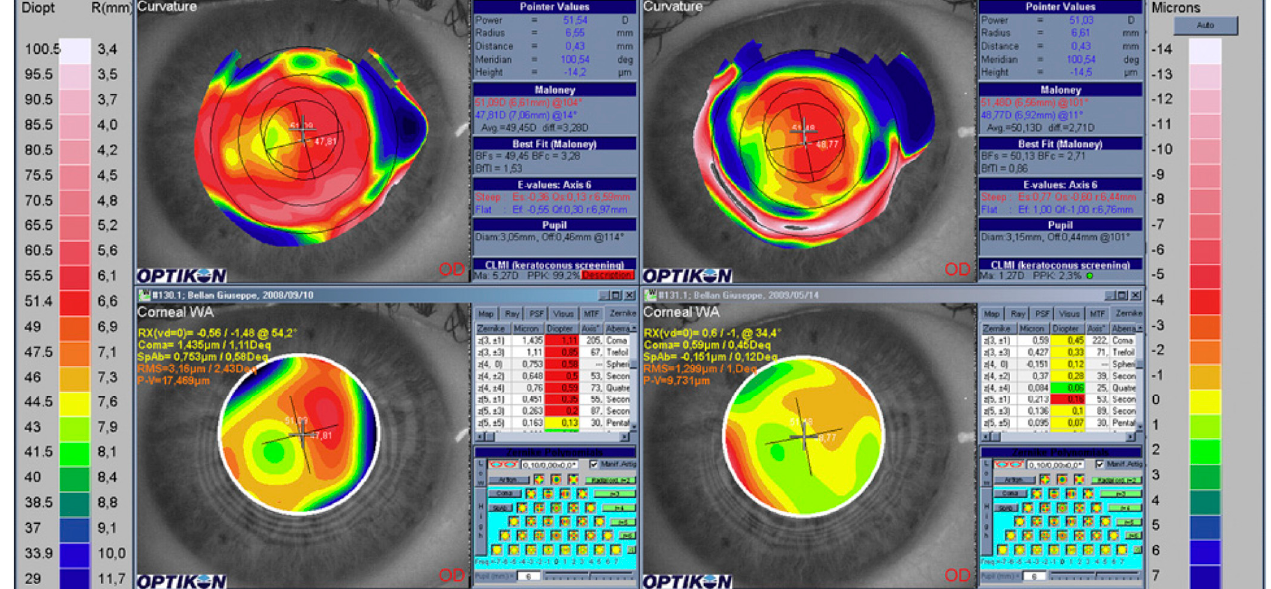
Figure 22. Maps of a post-RK eye. Top left: curvature map before simultaneous PRK–PTK. Top right: curvature map after simultaneous photorefractive keratectomy and phototherapeutic keratectomy (PRK–PTK). Bottom left: corneal wave aberration map before simultaneous PRK–PTK. Bottom right: corneal wave aberration map after simultaneous PRK–PTK. This figure was published in Ref. [112] Journal of Cataract & Refractive Surgery , M. Camellin and S.A. Mosquera, Simultaneous aspheric wavefront-guided transepithelial photorefractive keratectomy and phototherapeutic keratectomy to correct aberrations and refractive errors after corneal surgery, 1173–1180, Copyright Elsevier (2010).